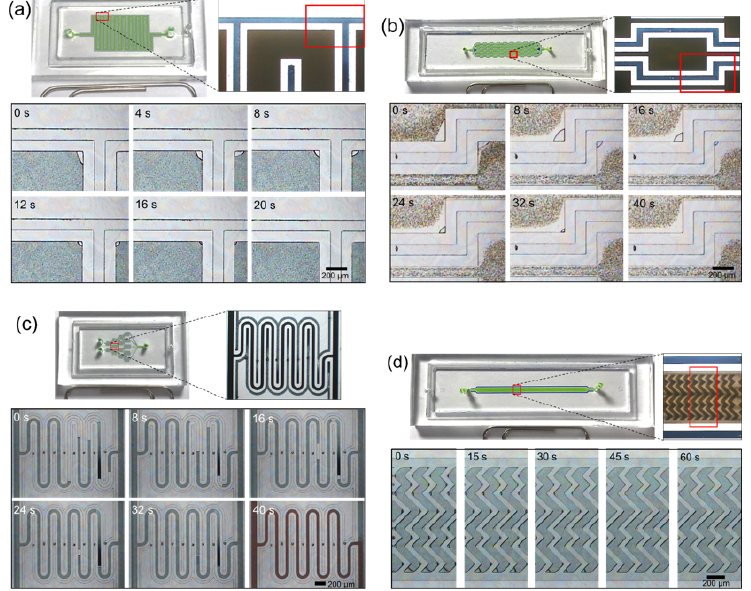
Figure 6. Sequential photographs showing bubble degassing in ( a ) a meandering microchannel, ( b ) a microvortex device, ( c ) a gradient micromixer and ( d ) a herringbone micromixer, fabricated by the disposable film-chip technique along with the lateral degassing method.